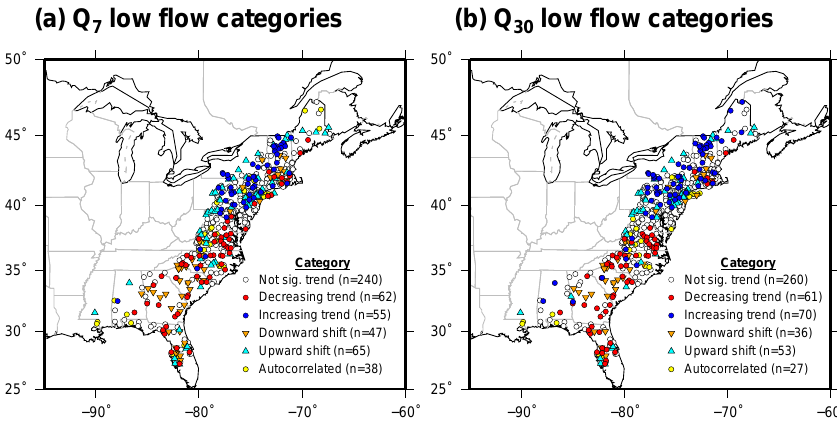
Figure 2. Categorization of nonstationarity of sites for Q7 and Q30.